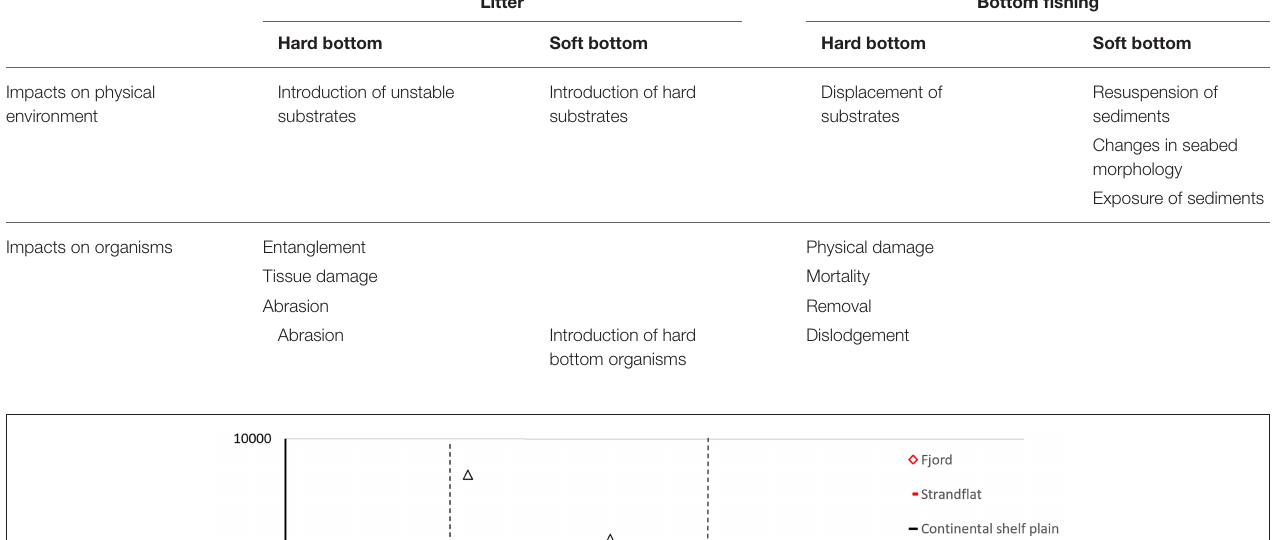
TABLE 3 | Overview of impact of litter and bottom fishing on physical environment and organisms on hard and soft bottom. Litter Bottom fishing Hard bottom Soft bottom Hard bottom Soft bottom